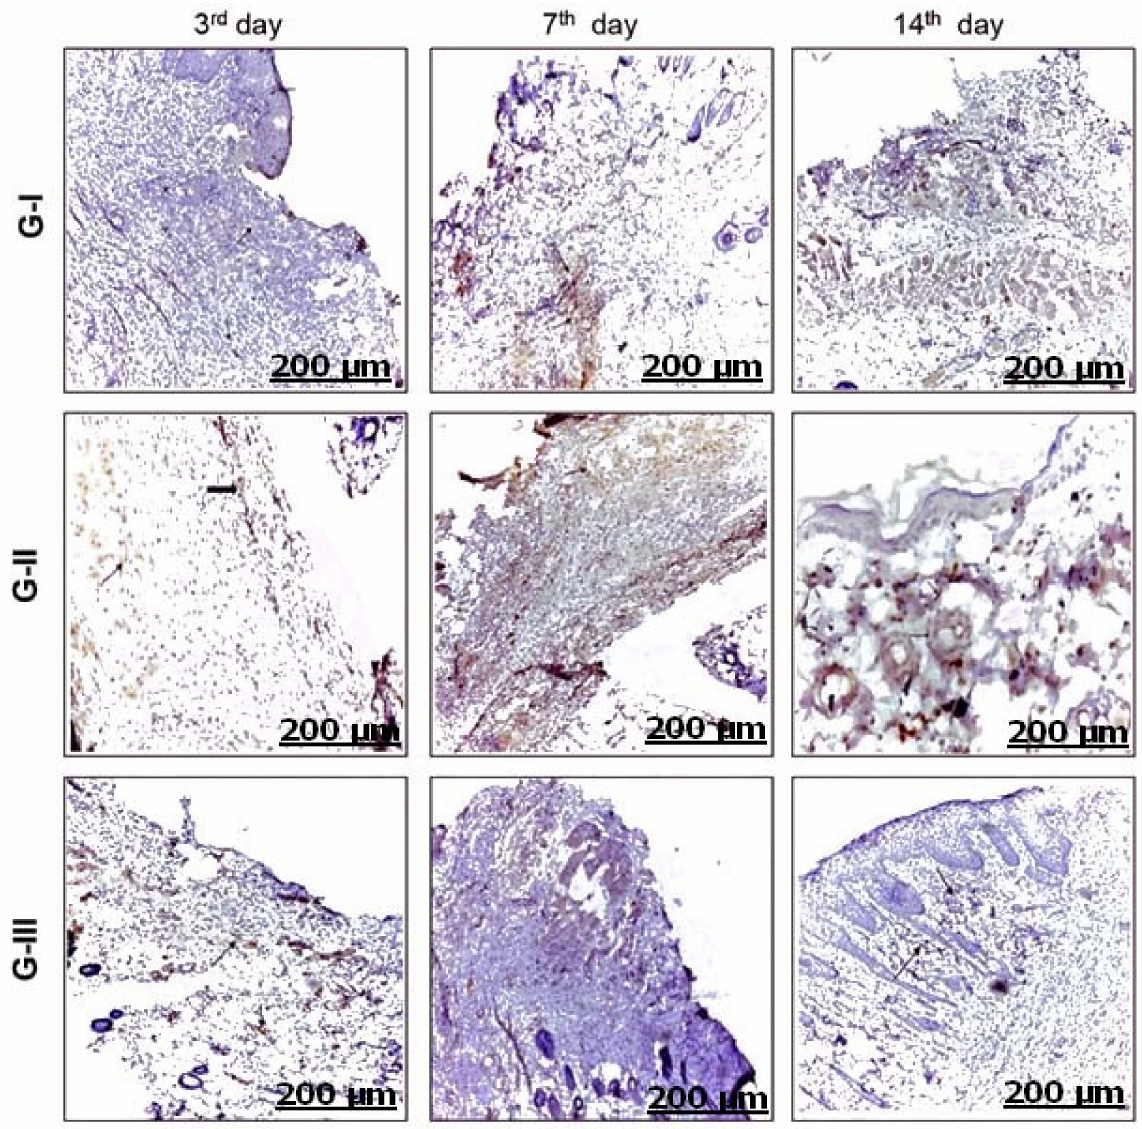
Figure 6. Immunohistochemical expression of VEGF in control and treated wounds. GI showed mild expression of VEGF within the endothelial cells of blood vessels and fibroblast on the 3rd, 7th, and 14th days. GII showed mild VEGF on the 3rd day within endothelial cells of blood vessels, which then increased on the 7th and 14th days within the fibroblast cells and endothelial cells of blood vessels besides epithelial cells of granulation tissue. In GIII, on the 3rd day, VEGF was mild within the endothelial cells of blood vessels, and increased on the 7th and 14th days and appeared within the endothelial cells of blood vessels, fibroblast cells, and epithelial